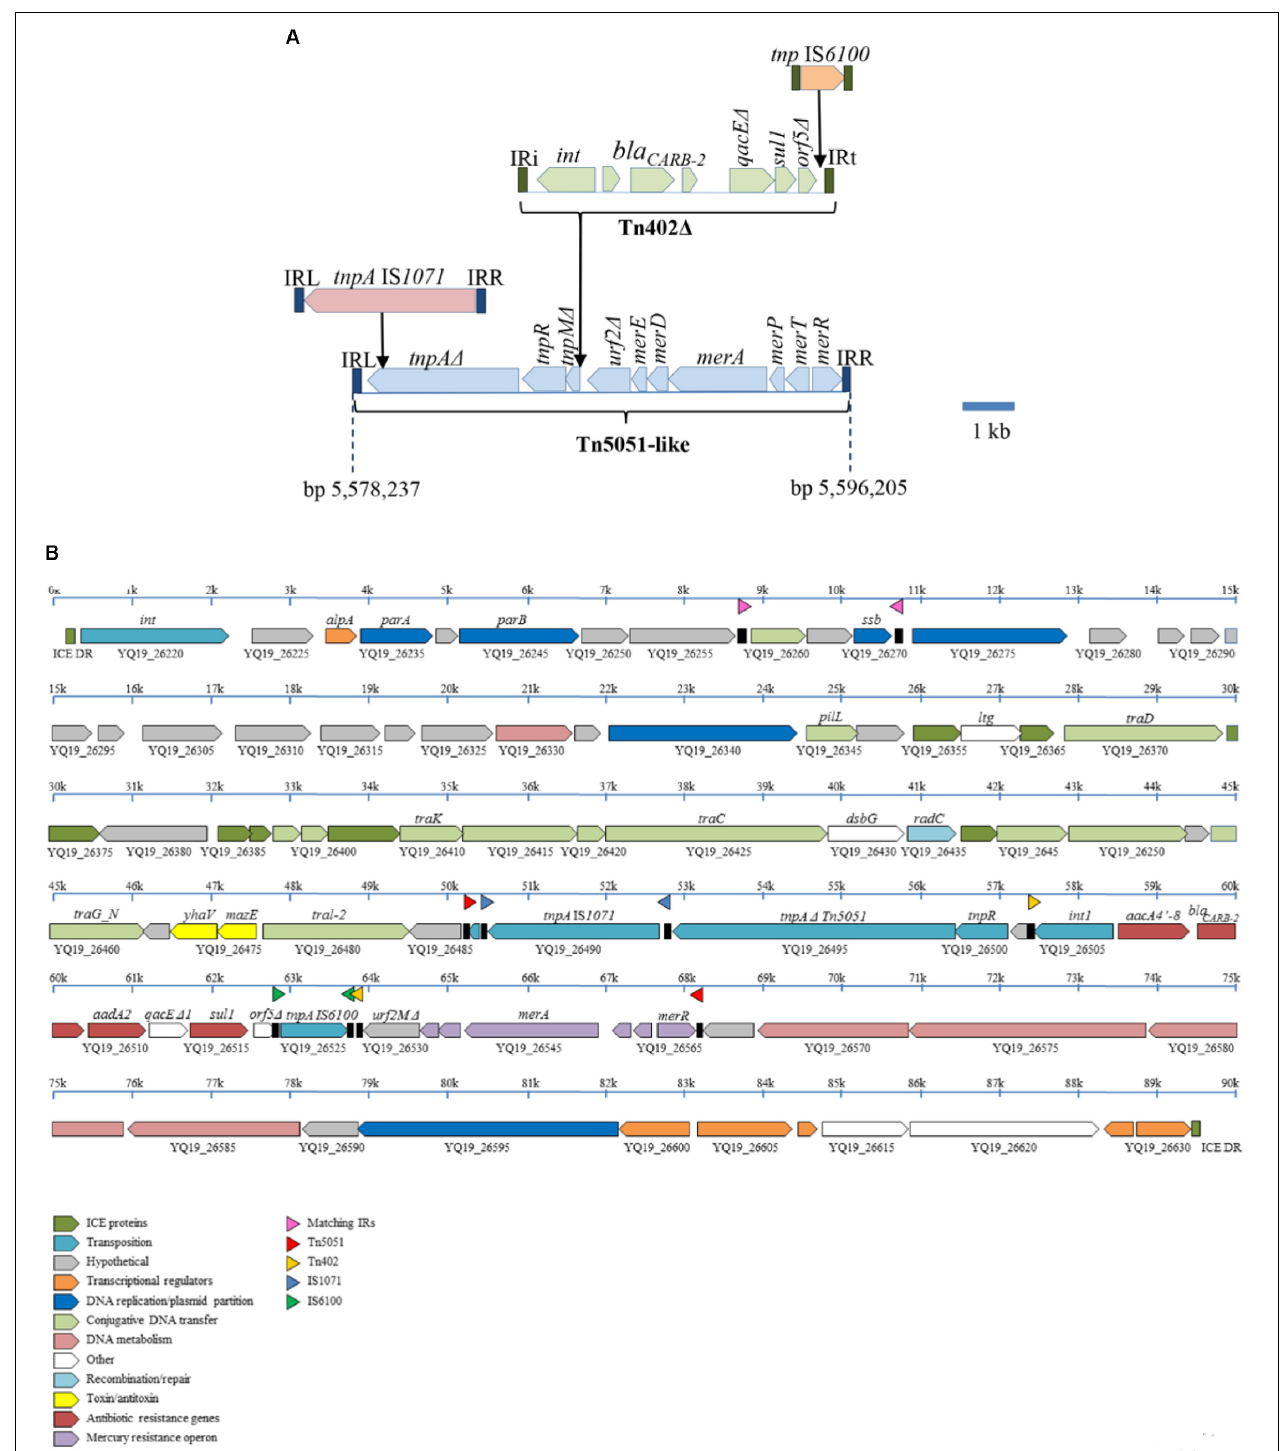
FIGURE 3 | Genetic context of the bla CARB − 2 -containing integron in Carb01 63. (A) Composition of a mosaic 18-kb transposon containing the integron with the bla CARB − 2 gene. Open reading frames of different transposable elements are indicated by different colors. (B) Composition of the ICE into which the composite transposon depicted in (A) is inserted. The ICE is bounded by 20-bp direct repeats (ICE DR). ORFs encoding proteins of different functional classes are indicated by different colors as outlined in the inset at the bottom. Inverted repeats are indicated by black boxes in between the ORFs with a colored triangle above.